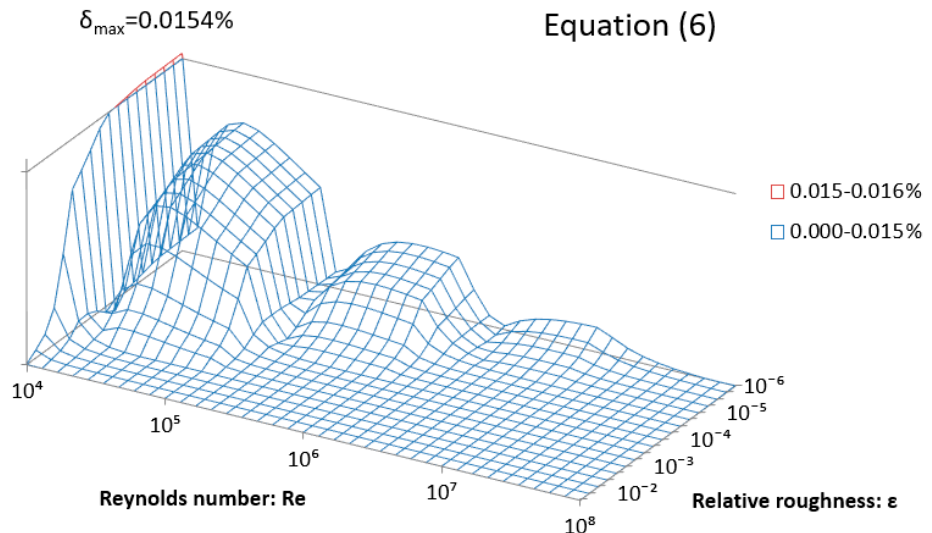
Figure 5. Distribution of the relative error for the approximation with two internal cycles and a starting point given by the rational function p o , Equation (2).